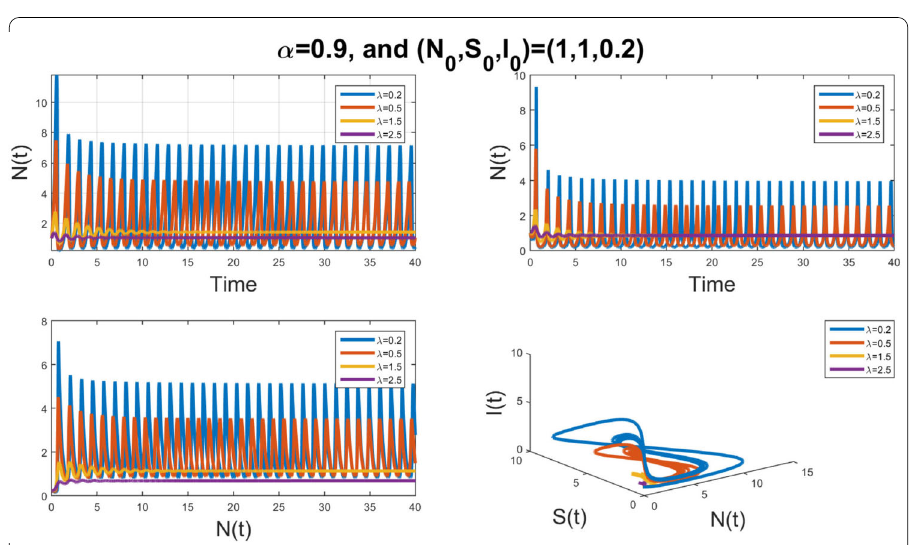
erate two DFEs, which is investigated through Theorem 2.1, and it is proved numerically using Fig. 1, where many scenarios can behold as the nonexistence of DFE, the existence of one DFE, or two. The existence of two DFEs highlights the possibility of the extinc- tion of the infection for consumer populations but in different levels (which is affected by the degree of cooperation between the two populations), which is affected principally by the value of the hunting cooperation rate a as it has been shown in Fig. 2 where the rate a can dominate the existence and the multiplicity of DFE. Further, the stability of this equilibrium can hold, which is considered through numerical simulation in different sce- narios, as in Fig. 3 we have the stability of DFE, and in Figs. 4, 8 we have the extinction of infected consumers as a form of oscillations. Besides, the persistence of the